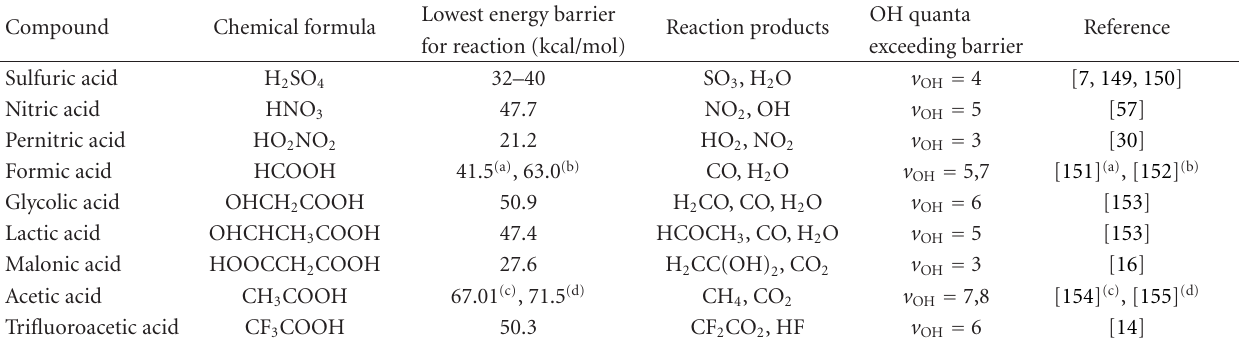
Table 1: Organic acids and barriers for their chemistry.